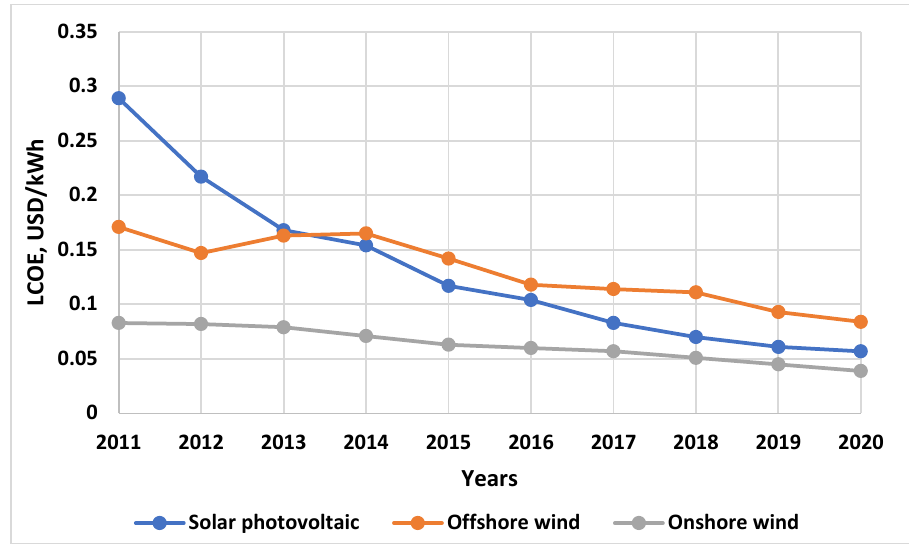
Figure 1. Global levelized cost of solar photovoltaic, offshore, and onshore wind energy in 2011–2020, developed by authors using [2].